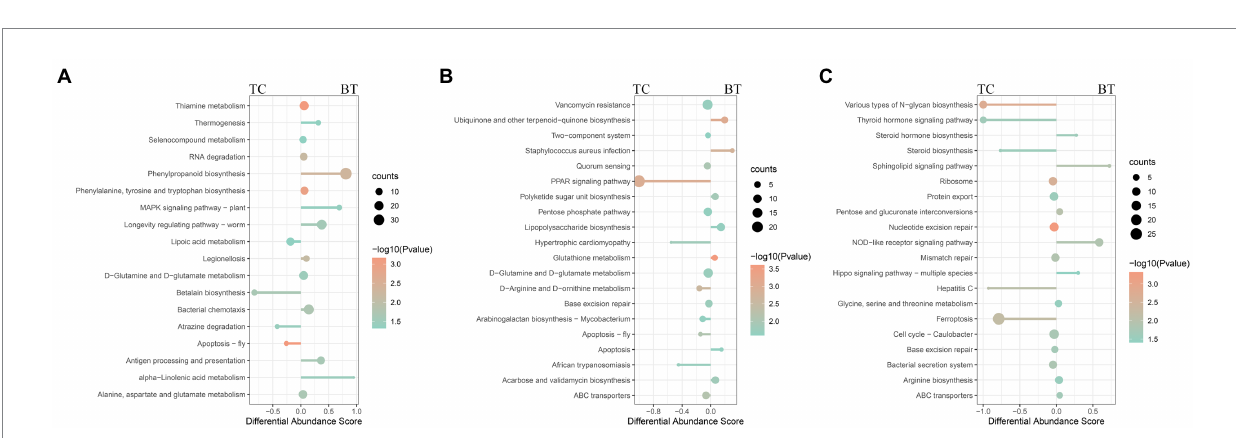
FIGURE 8 Enrichment analysis of KEGG pathway through the intestinal metagenome. Pathways were grouped by stages: (A) pre-weaning stage, (B) weaned stage, and (C) growth stage. Each point represents a pathway, the size of each point is proportional to the counts, and the color of the point indicates their p -values. The length of the line represents the differential abundance score (DAS) calculated by the relative gene